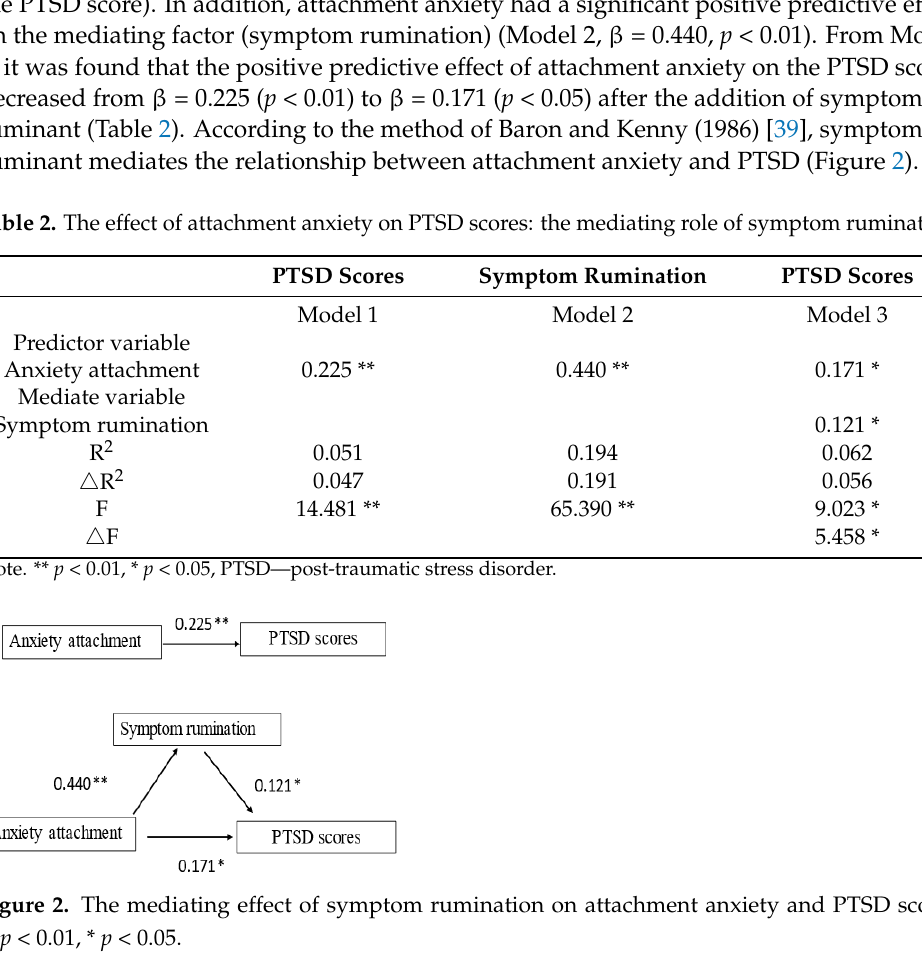
Table 2. The effect of attachment anxiety on PTSD scores: the mediating role of symptom rumina- tion.